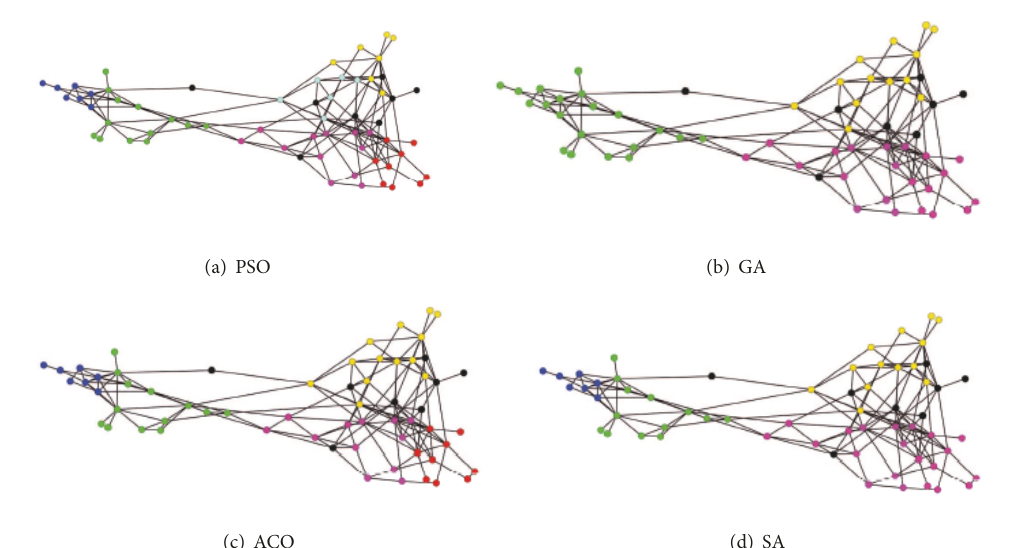
Figure 8: The comparison on different optimization algorithms on dolphins (the black nodes are overlapping nodes).